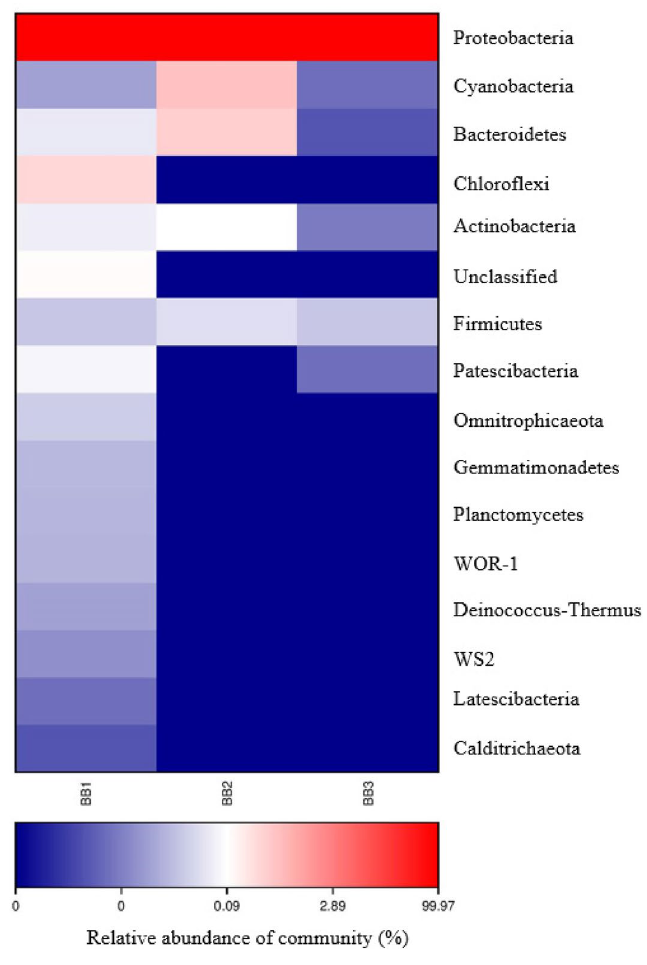
Figure 5. Heatmap analysis of three samples, BB1, BB2 and BB3 from starved bed